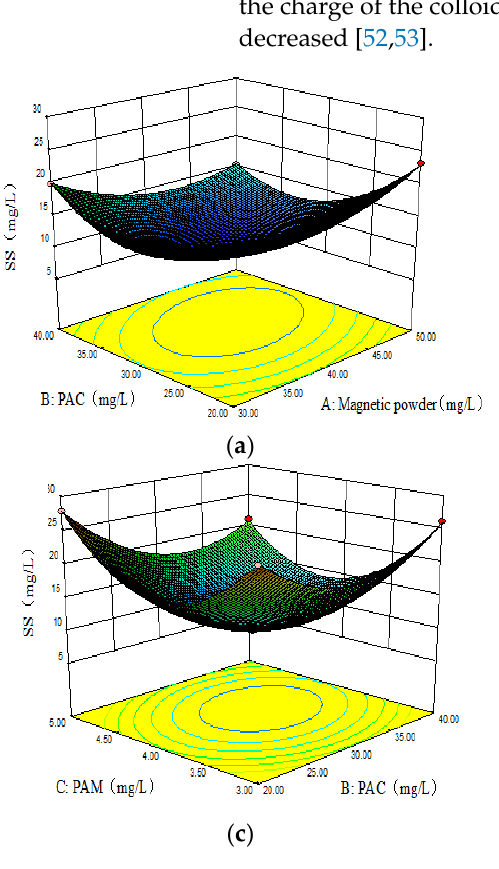
Figure 2. Response surface diagram of interaction among various factors (SS) ( a ) magnetic po3wder and PAC ( b ) magnetic powder and PAM ( c ) PAC and PAM.